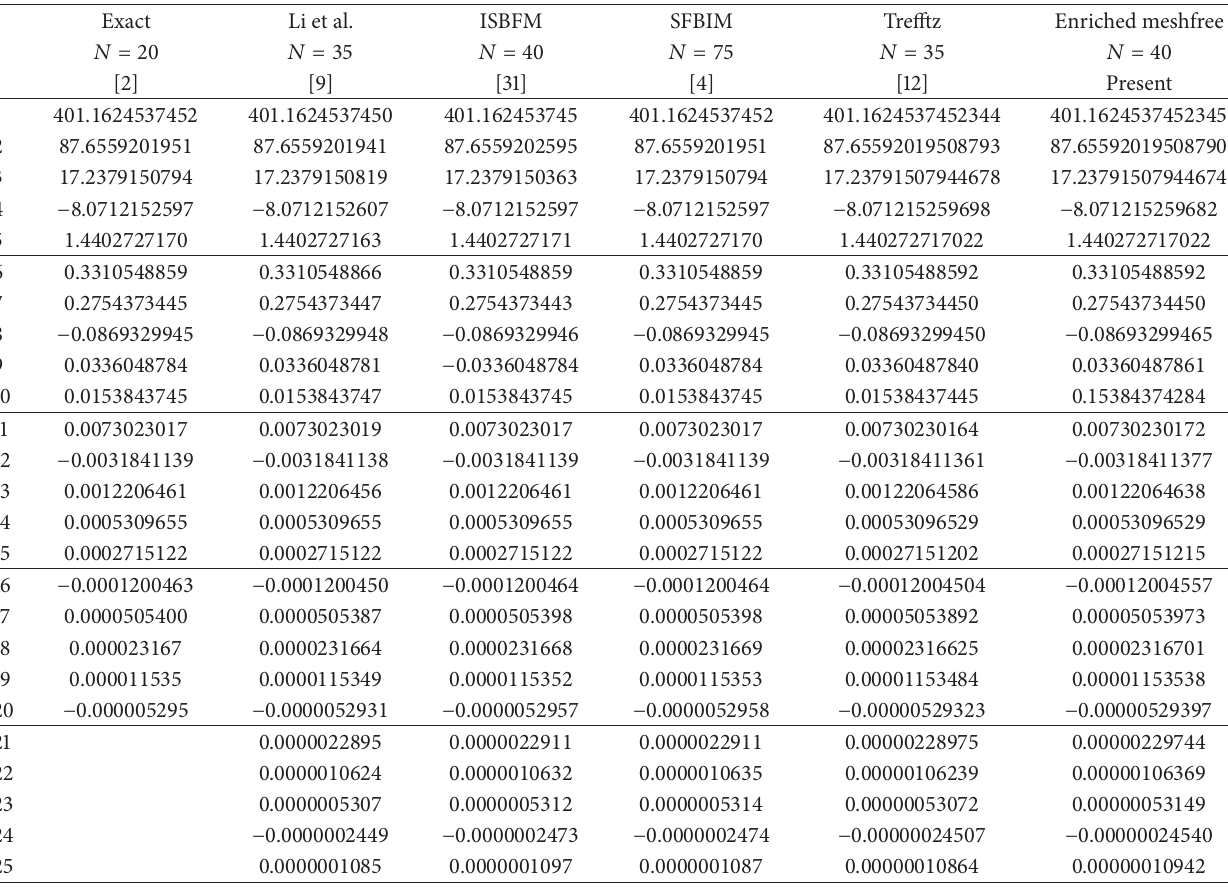
Table 4: Comparison of the first 25 coefficients obtained by other methods.